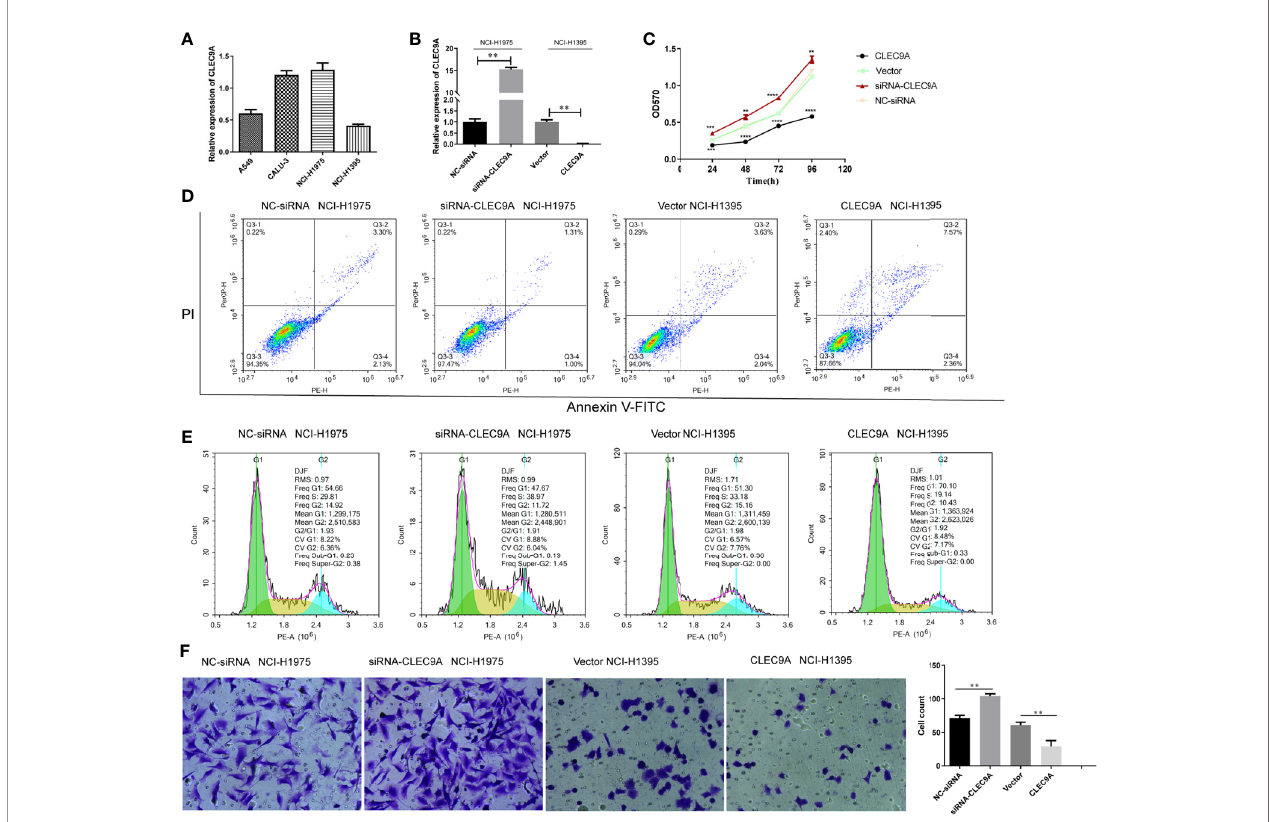
FIGURE 8 | Impact of CLEC9A on the proliferation, apoptosis, cell cycle distribution, and invasion of human LUAD cell lines. (A) CLEC9A expression level in A549, Calu-3, NCI-H1975, and NCI-H1395 cells was detected by RT-qPCR. (B) Transfection ef fi cacy in NCI-H1975 and NCI-H1395 cells was detected by RT-qPCR. (C) The impact of CLEC9A expression on the proliferation was determined by MTT assay. (D) Cell apoptosis ratio was measured by using the Annexin V-FITC/PI double staining. (E) Cell cycle distribution was evaluated by using fl ow cytometric analyses. (F) Cell invasion was performed by using transwell assay. ** p < 0.01, *** p < 0.001, **** p <